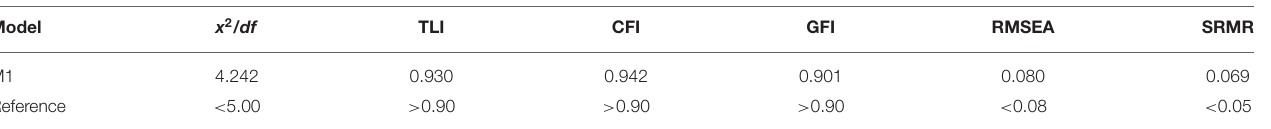
TABLE 3 | Fitting indicators of the mediation model of exercise value cognition.